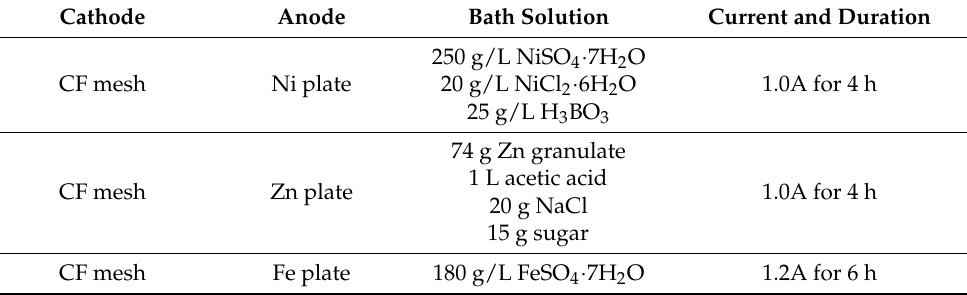
Table 8. Details of electroplating metals on carbon